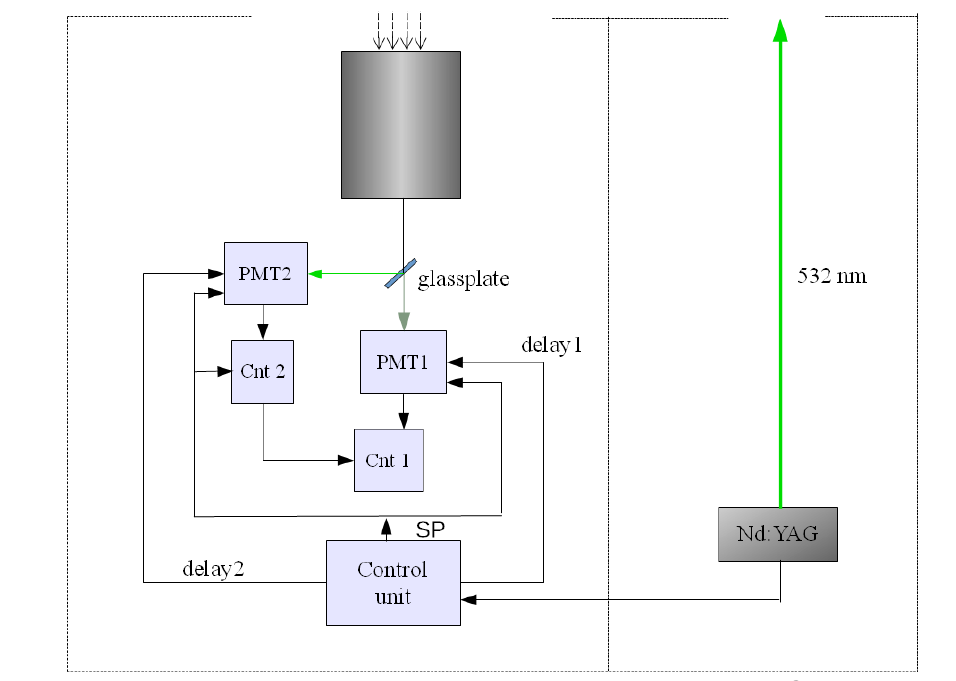
Fig. 1. Lidar scheme: SP - sync pulse generated by laser, Cnt - photon counter. PMT - photomultiplier tube, delay - blocking pulse duration μs, set in the control